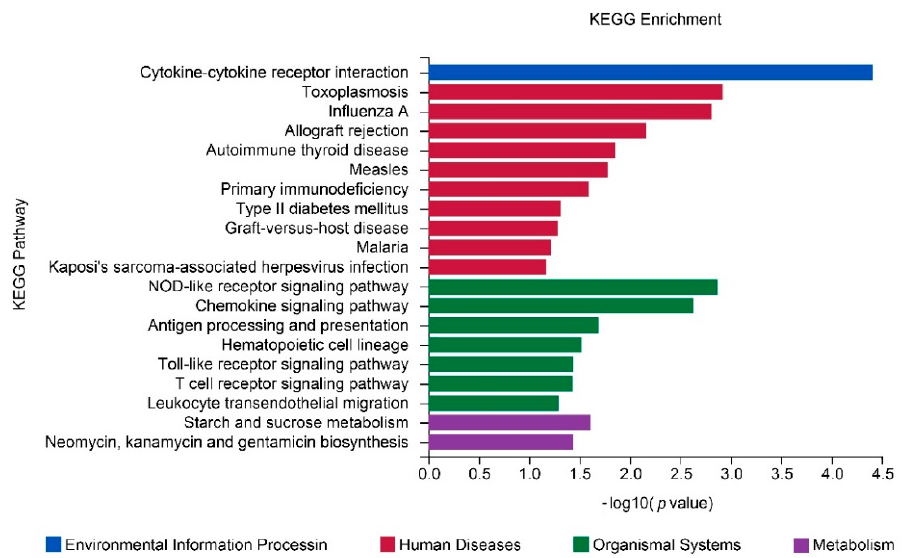
Figure 8. Enrichment KEGG pathways of DEGs in the aorta. The DEGs were charted into the KEGG datasets, and significantly enriched KEGG terms were ascertained by p < 0.05. n = 3 for each cohort.